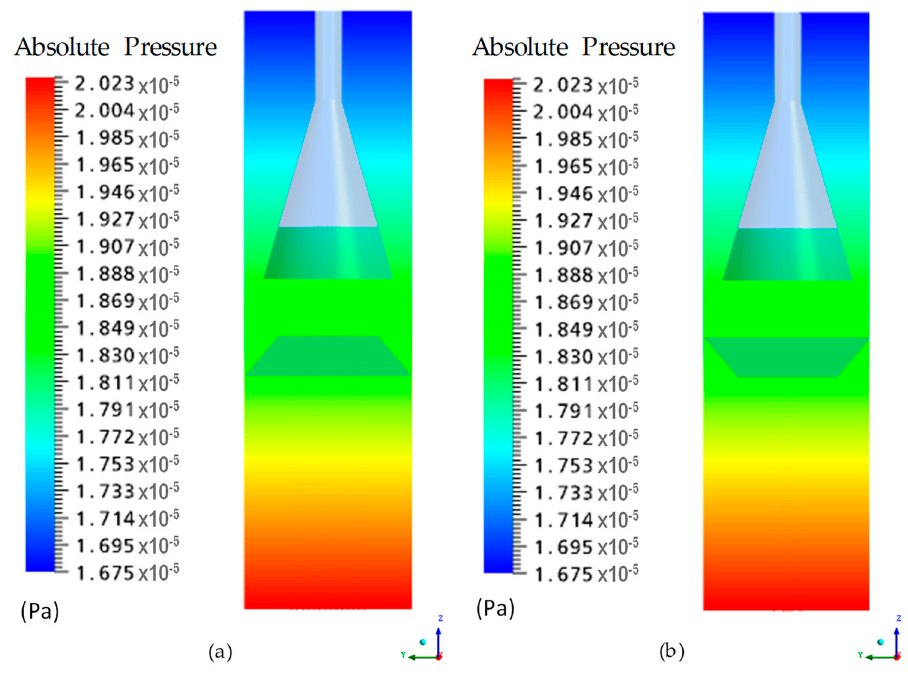
Figure 18. Pressure field inside the UASB reactor, considering the three-phase system: ( a ) deflection inclination upwards ( b ) deflection inclination downwards.